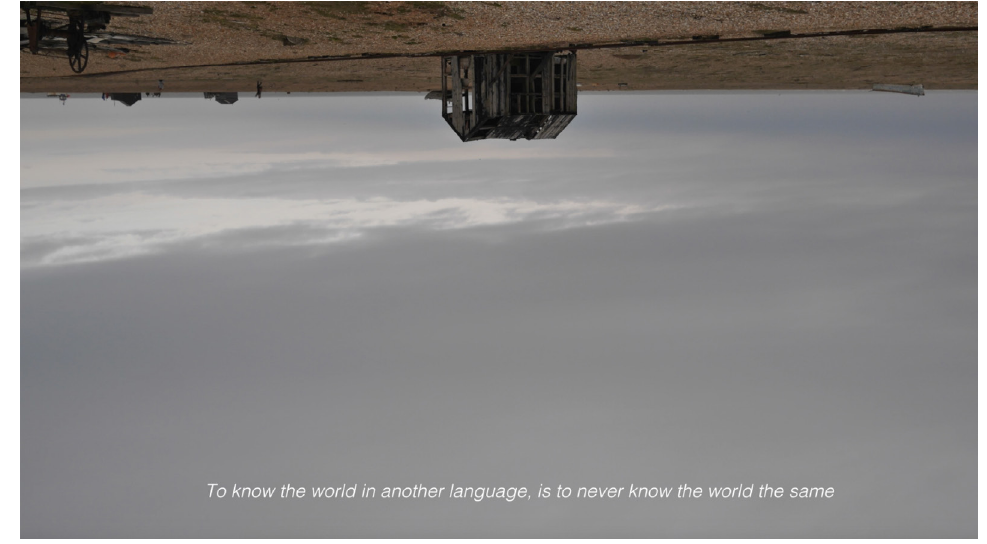
Figure 5. Still from Kate McMillan, The Lost Places , UK, 2017 (translation of Deryn Rees-Jones’ poem “Home”).